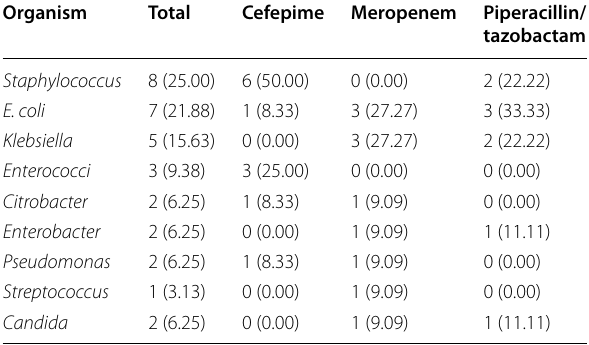
Treatment efficacy